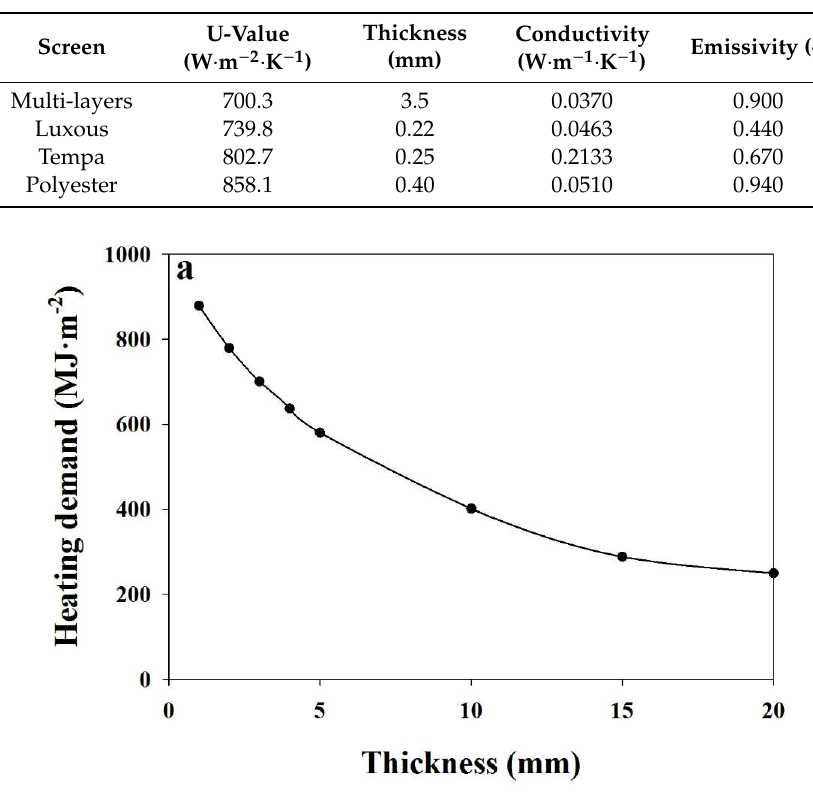
Figure 13. Sensitivity analysis of thermal conductance of thermal screens ( a ) heating demand ( b ) sensitivity coefficient. Table 8. Calculated heating demand with the material’s properties.